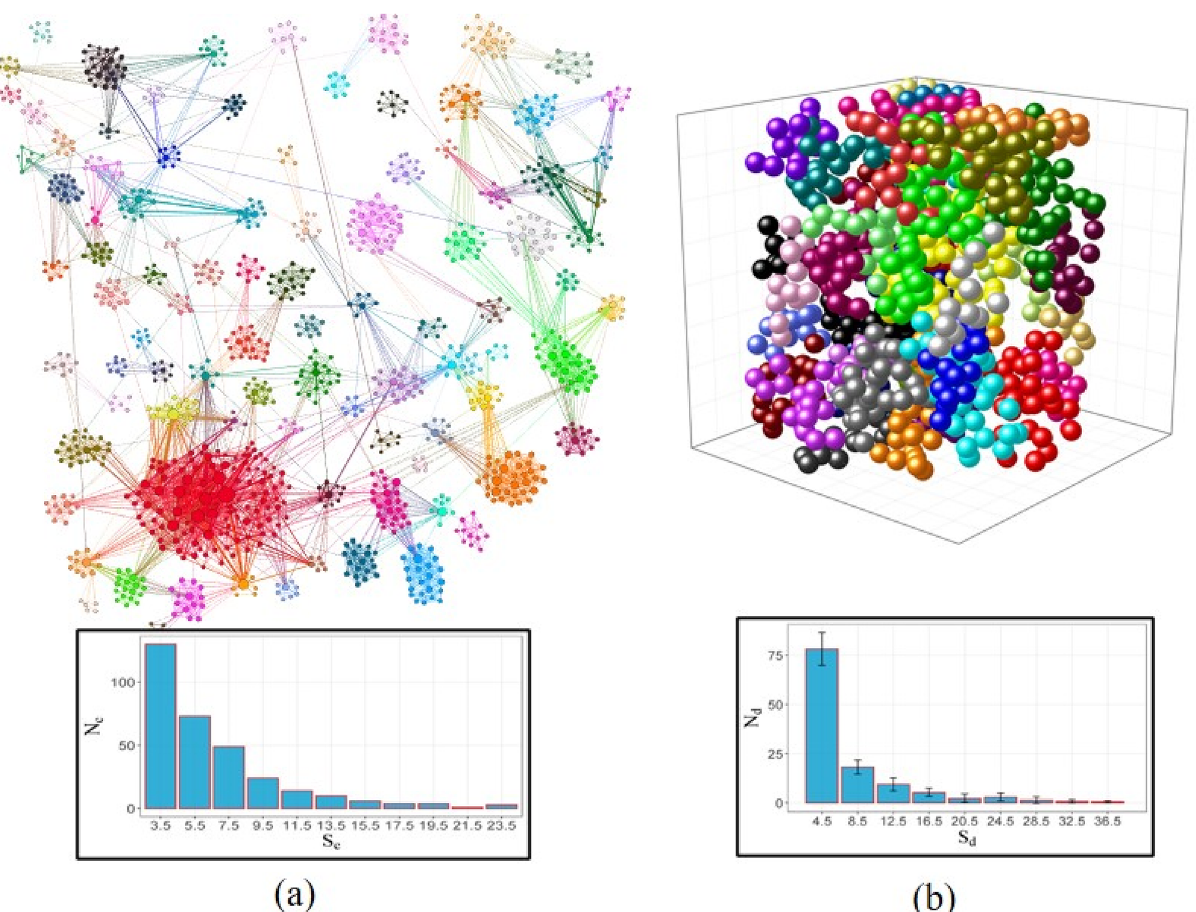
Figure 5. Images of ( a ) giant component of the core Shell nanoparticles network, showing the communities that have more than 4 nodes and ( b ) magnetic domains that have more than 10 spins, for a distribution of simulated atoms with t p = 27. The histograms inserted in ( a ) and ( b ) represent the size distribution of the communities and domains,